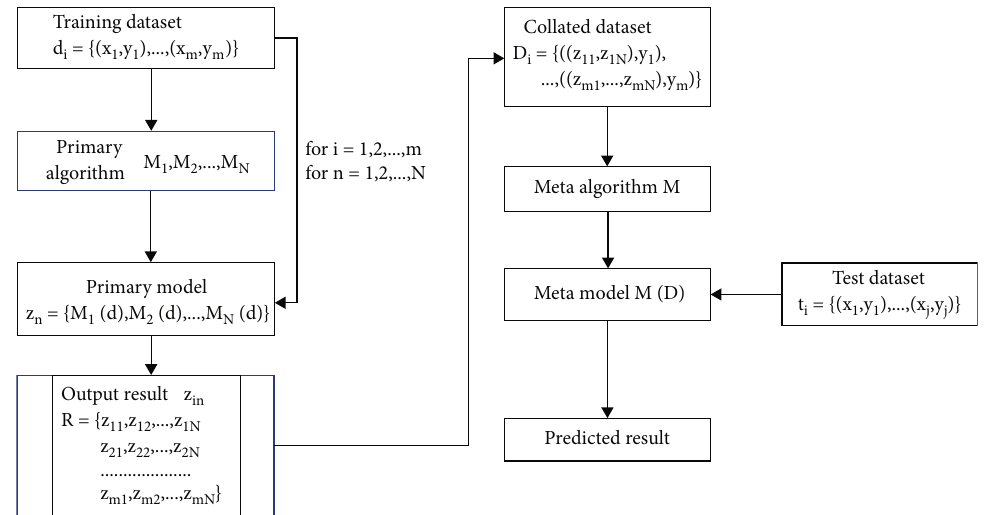
Figure 3: Operating principle of the stacking